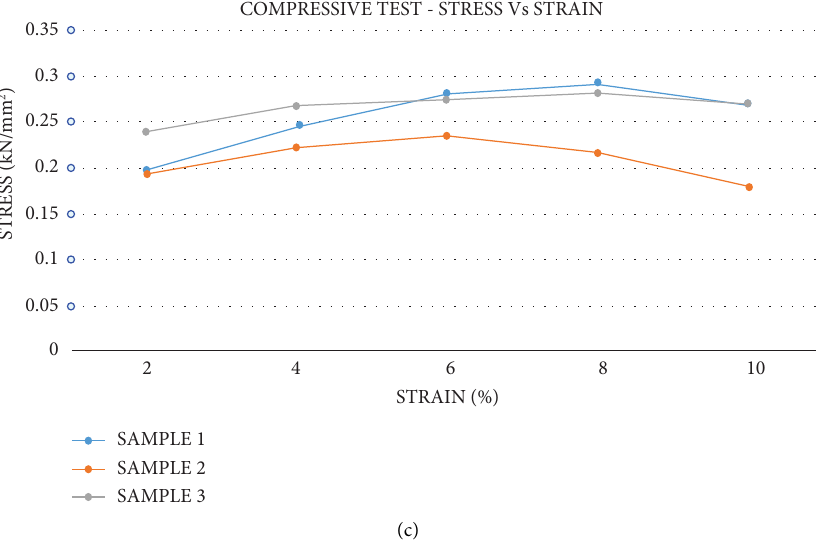
Figure 5: (a) Compressive test results; (b) relationship of load and displacement for the composites; (c) stress vs. strain curve for the compressive test.